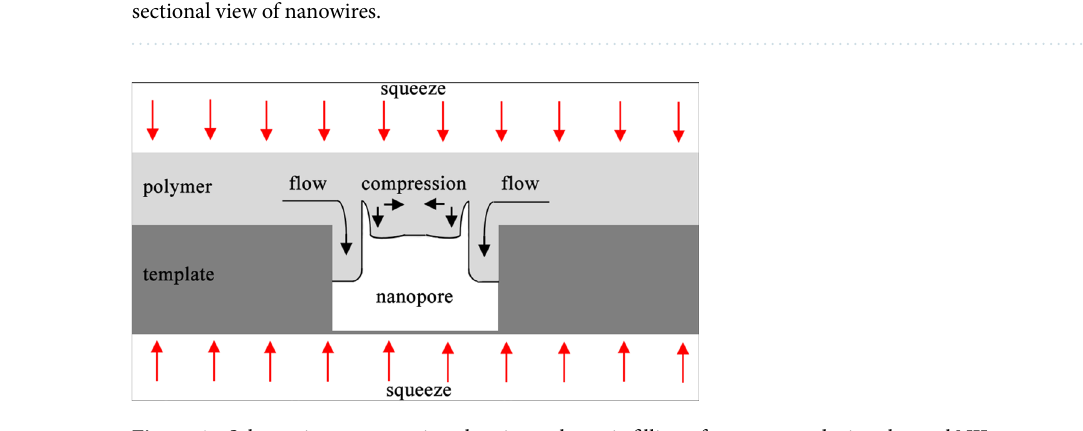
Figure 4. Schematic representation showing polymeric filling of a nanopore during thermal